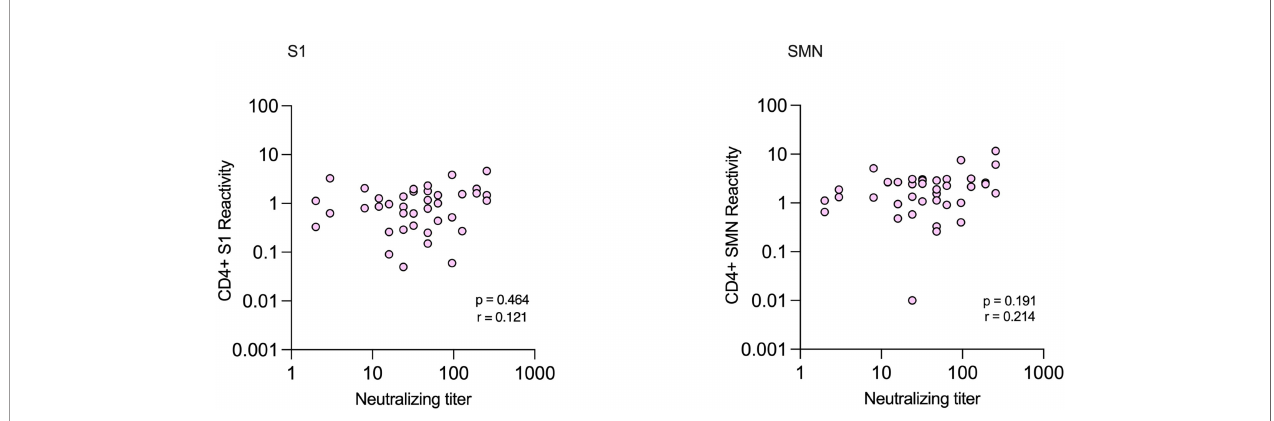
FIGURE 7 | Correlations between CD4 + T-cell reactivity against S1 and SMN peptide pools and neutralizing antibody titers in health care workers with veri fi ed COVID-19.